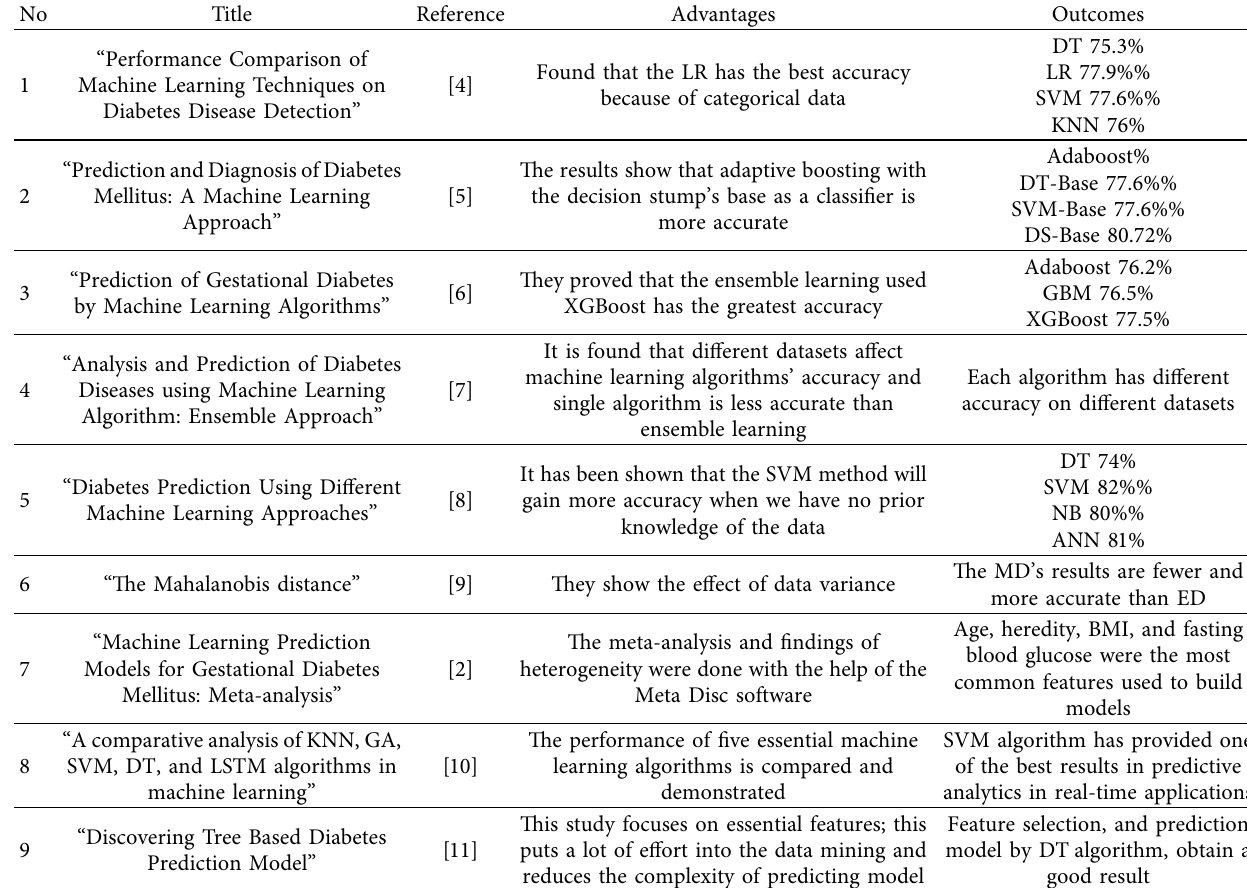
Table 1: Summarizes and differences of the related